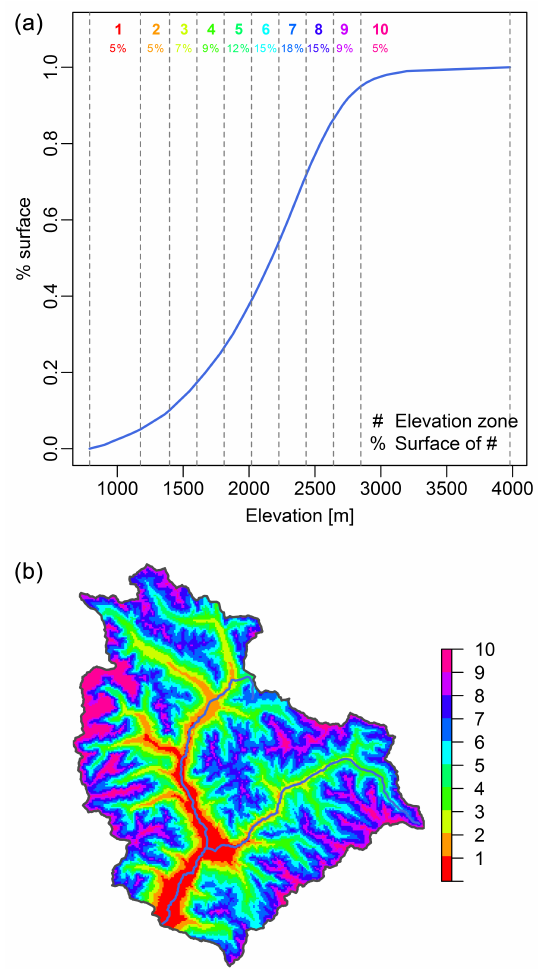
Figure 2. Durance at La Clapière catchment: (a) hypsometric curve and (b) elevation